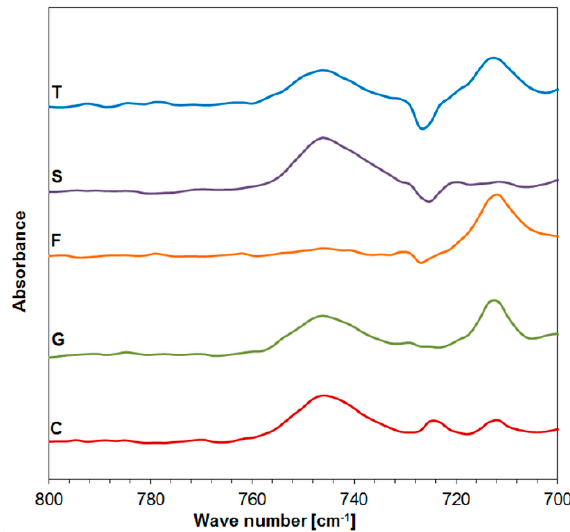
Figure 2. FTIR spectra of calcium carbonate particles precipitated without additives ( C ), with glucose ( G ), fructose ( F ), sucrose ( S ) and trehalose ( T ).